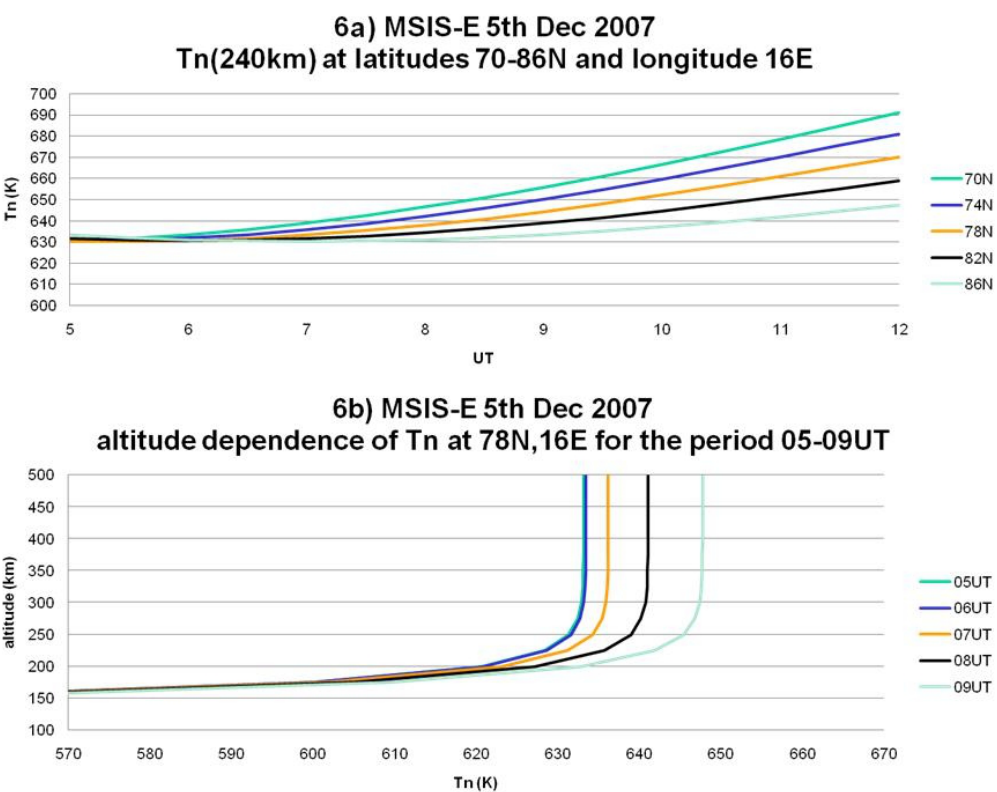
Figure 6: Corresponding temperatures from the MSIS-E semi-empirical model for measured temperatures in Figure 5 by (a) latitude and (b) height.